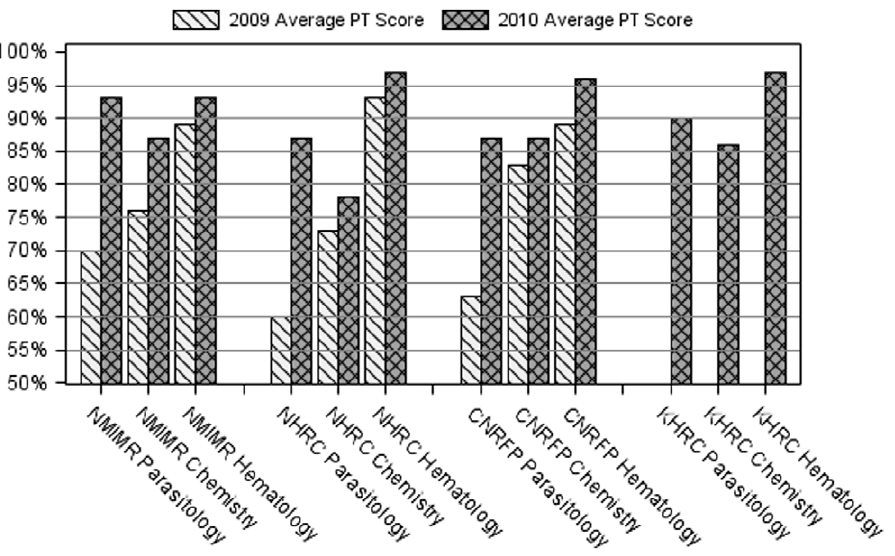
Figure 3. Performance by Center for 2009 and 2010 for blood parasites, chemistry and hematology.